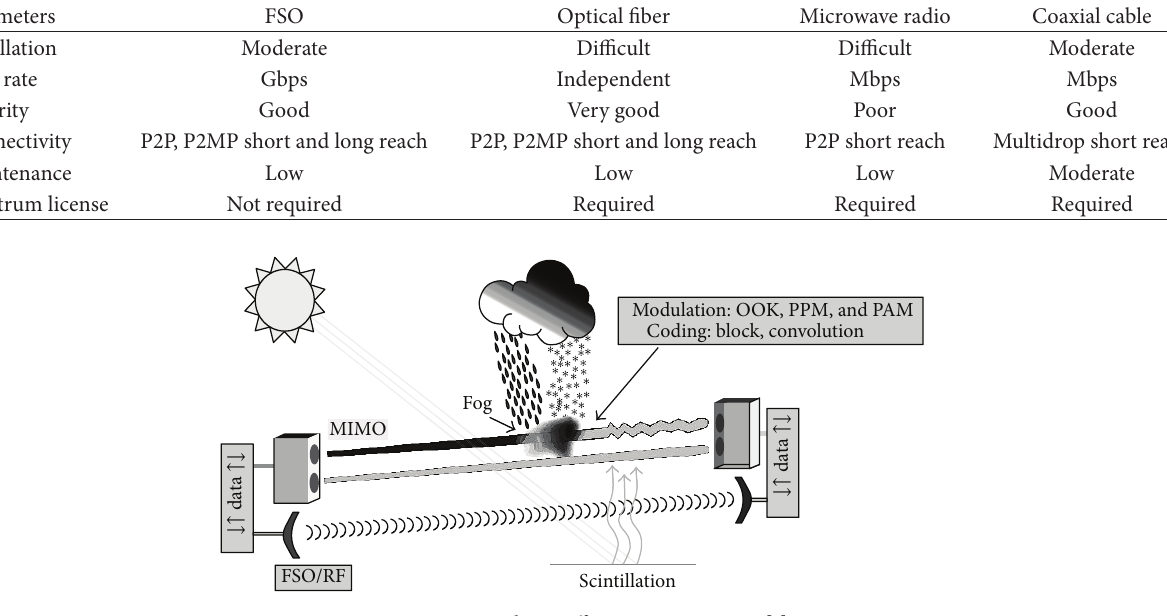
Figure 1: Atmospheric effects on FSO system